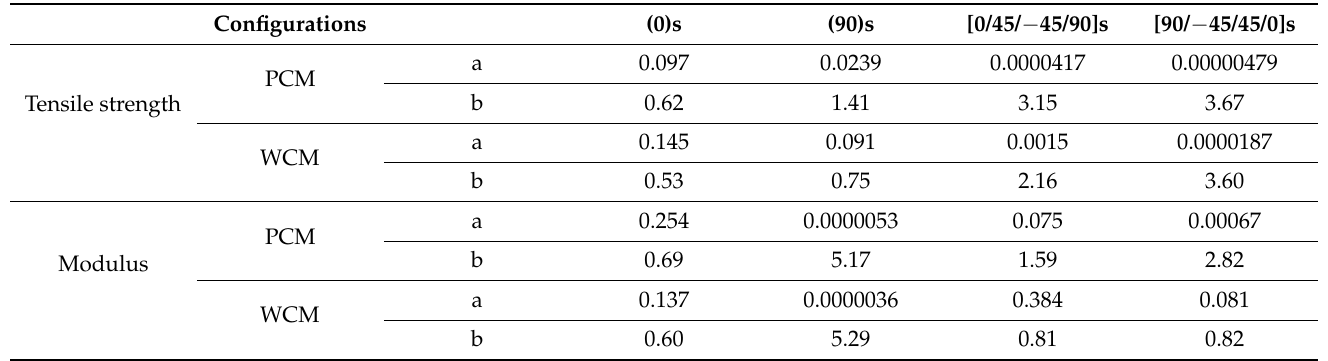
Figure 8. Effect of strain rate on modulus of different configurations: ( a ) (0)s; ( b ) (90)s; ( c ) [0/45/−45/90]s; ( d ) [90/−45/45/0]s. Table 2. Values of the two strain rate factors for different configurations made using different processes.